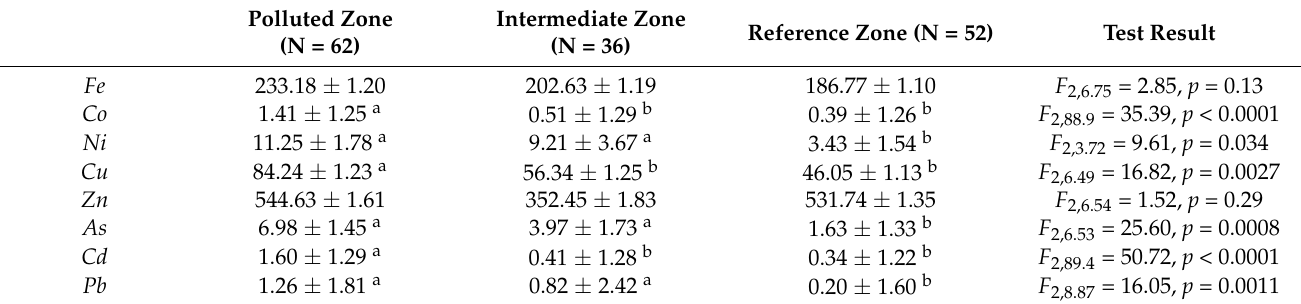
Table 1. The average heavy-metal concentrations ( µ g g − 1 ± 95% confidence interval) of Vespula vulgaris specimens in the three studied pollution zones and the results of linear mixed models. The same letter symbol for the metal levels denotes a statistical pairwise similarity between sites (Tukey’s test p >